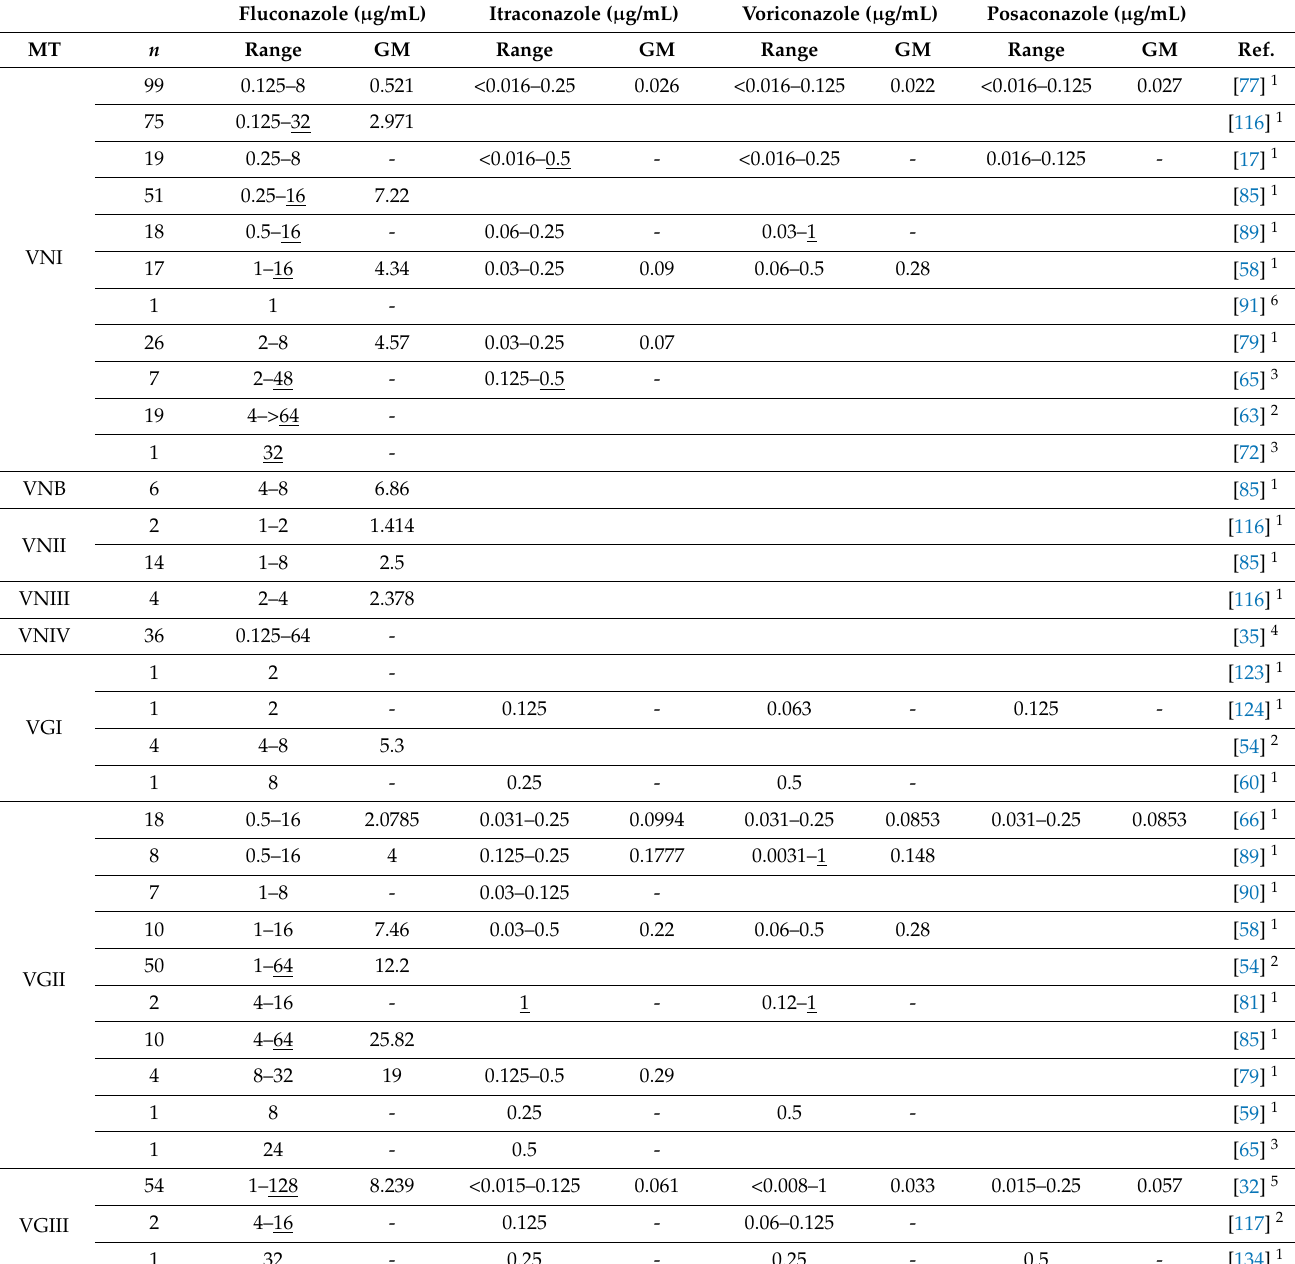
Table 4. Minimum inhibitory concentrations of azoles for Cryptococcus neoformans and Cryptococcus gattii species com- plexes isolates from Latin America, according to the molecular type. Non-wild-type minimum inhibitory concentrations are